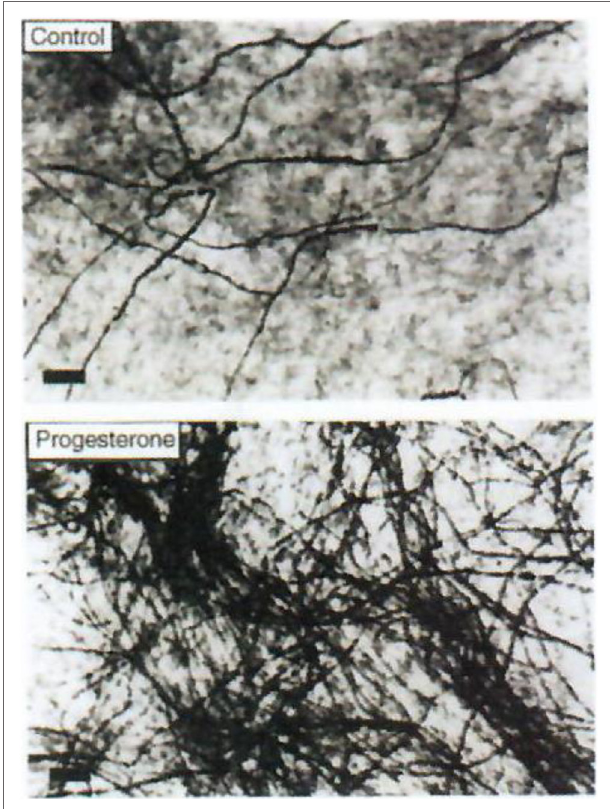
FIGURE 4 | Effect of progesterone on myelin formation in DRG cultures. Cells were cultured for 2 weeks in myelination-promoting medium in the absence (top) or presence (bottom) of 20 nM progesterone. Myelinated fibers were stained with Sudan black and the number of myelin segments was determined. Only myelinated fibers are visible on these photographs. Scale bars, 40 µm. Data from Koenig et al.